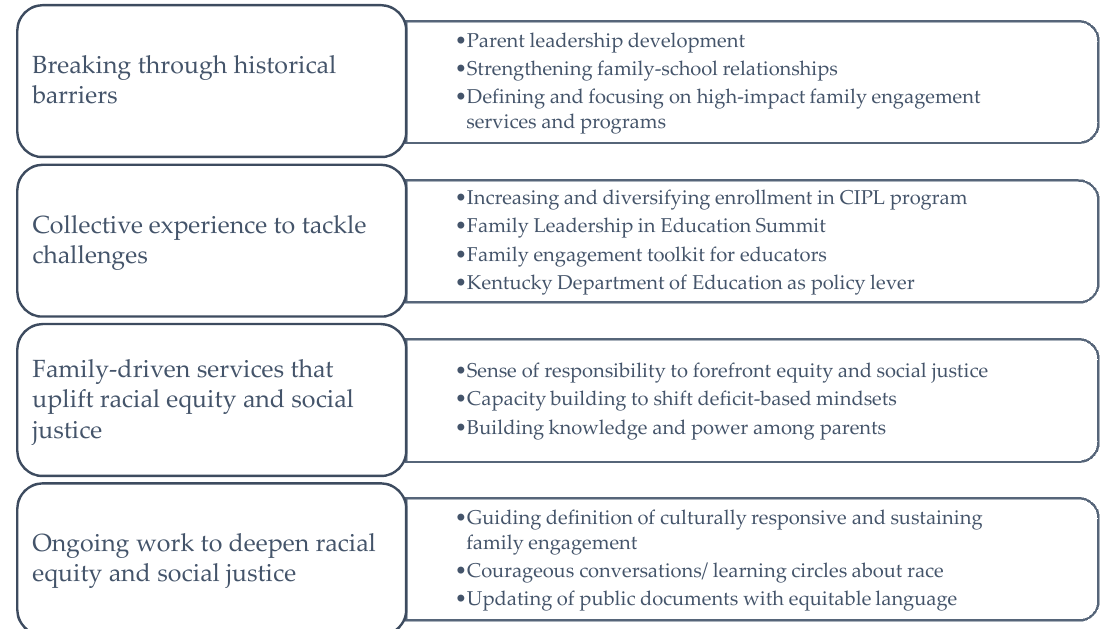
Figure 3. Main themes from KY Collaborative data.